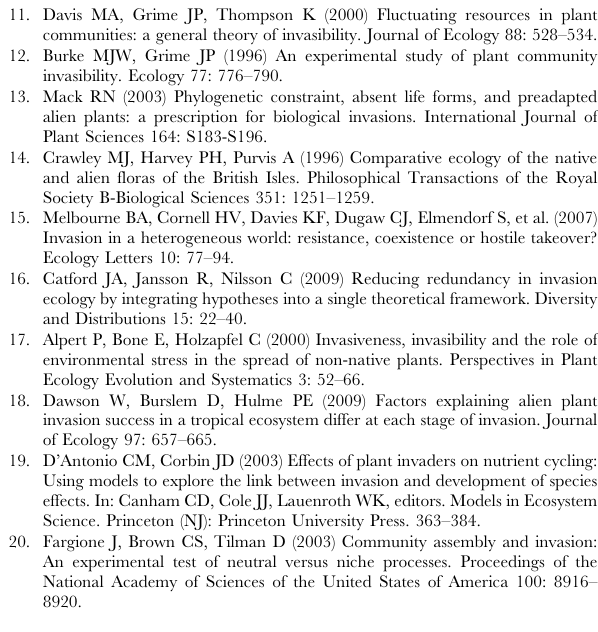
Figure S3 Left- Picture of a current-year shoot of Ailanthus altissima , showing that the same current-year stem bears leaves and inflorescences, which were derived from the same VR bud (see text) (April 2009). Centre- Picture of two recently opened buds of Robinia pseudoacia . It can be observed that both leaves and inflorescence derived from the same VR buds (March 2009). Right- Picture of a female inflorescence of Populus alba . It can be seen that the inflorescence grew on the previous-year stem from a R bud, while the apical vegetative (V) bud, enclosing the current- year vegetative organs, is still close (March 2009). Pictures by the authors. Table S1 Phenological data of the studied species. Table S2 Branch production data of the studied species. Table S3 Secondary growth of the studied species. Table S4 Comparison of shoot production between sexes in Ailanthus altissima